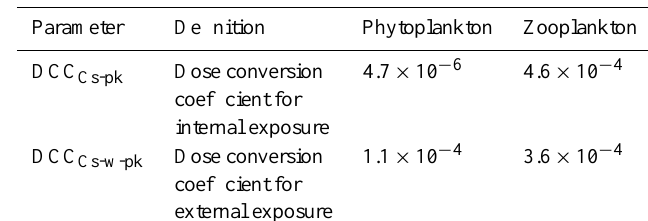
Table 1. Parameter values used in the absorbed dose calculation. All units are inµGyh − 1 perBqkg − 1 .